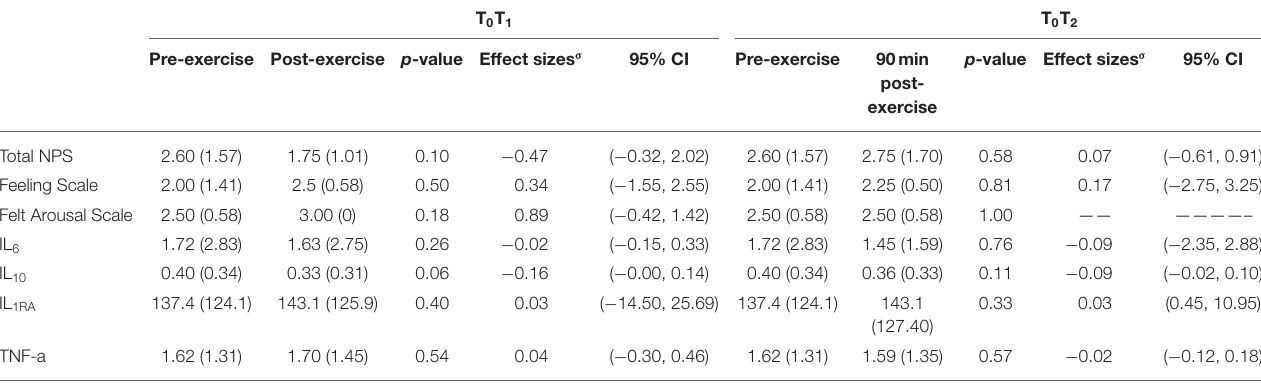
Data are presented as Mean (SD); σ Hedge’s g av ; Neuropathic Pain Scale (NPS) values are a composite value of 10 items rated on a numerical rating scale ranging from 0 to 10 (0 = no pain, 10 = worst pain imaginable). Feeling Scale (FS) is a single item rated on a bipolar scale ( − 5 = very bad, + 5 = very good). Felt Arousal Scale is a 6-item scale rated on a 1–6 numerical rating scale (1 = low arousal, 6 = high arousal). Cytokines are measured in